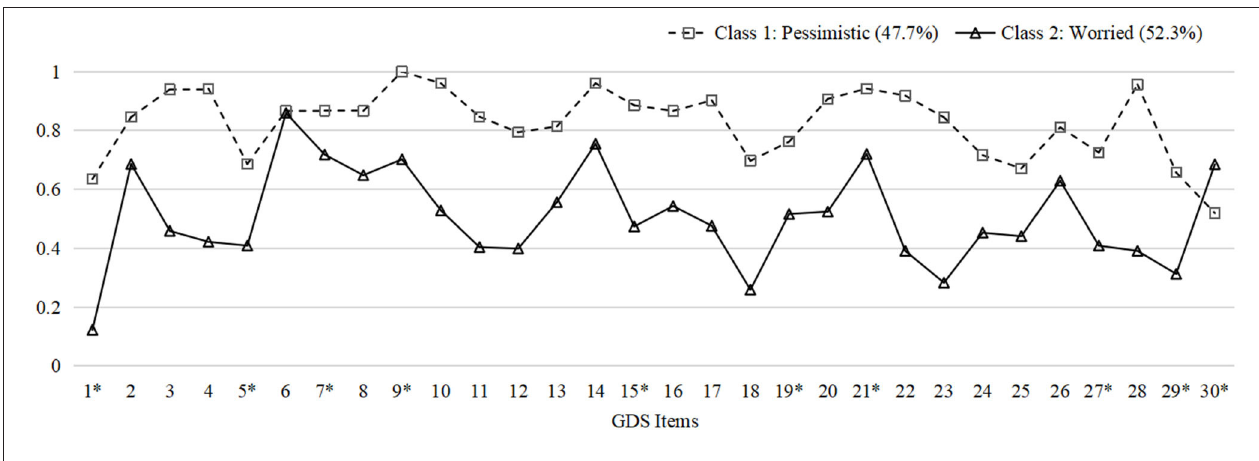
Table 2 shows the sociodemographic and